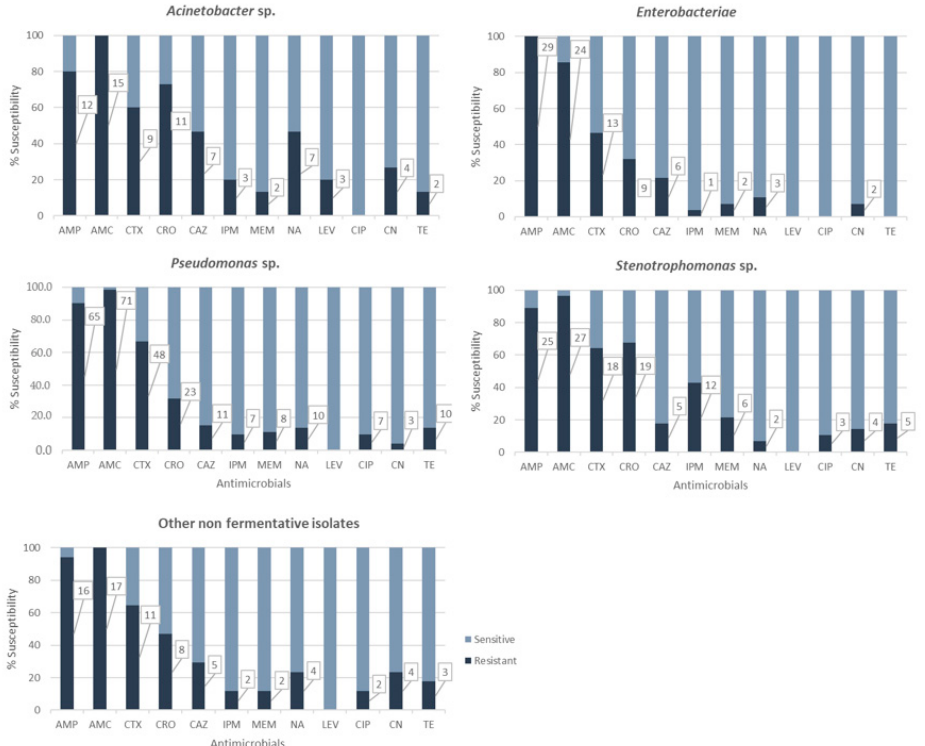
Figure 1. Antimicrobial resistance for each bacterial group; denotes significant differences between bacterial groups. Numbers in boxes correspond to number of resistant isolates.